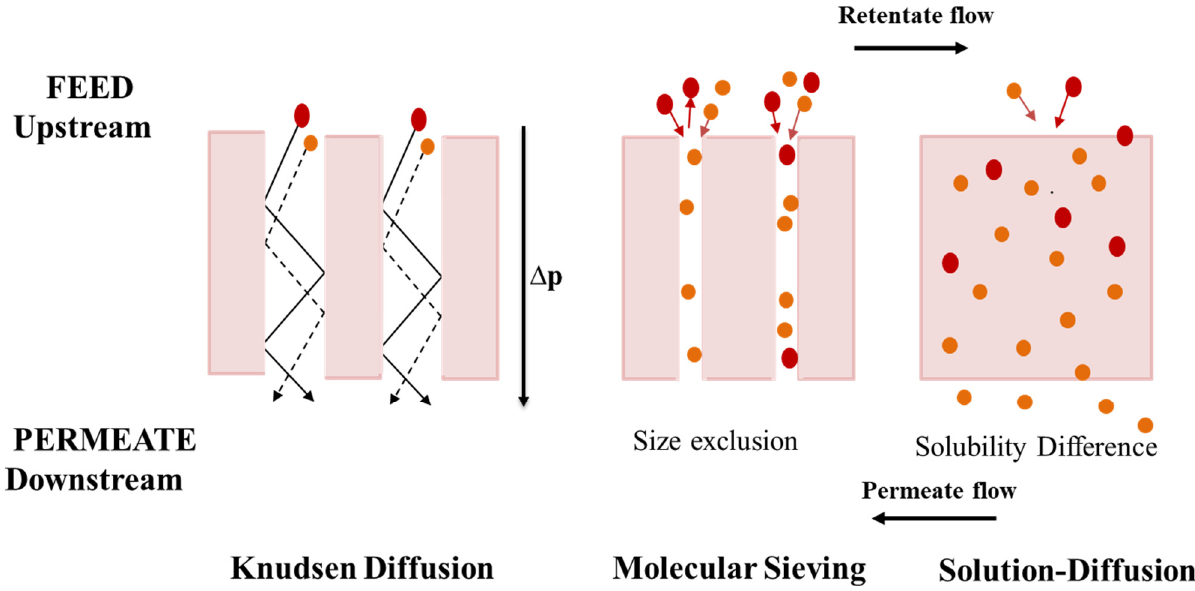
Figure 3. Schematic representation of the three mechanisms for gas mixture separation in membranes: diffusion—Knudsen diffusion, molecular sieving, and solution-diffusion. Orange circle (molecule A), Red circle (molecule B). The figure was adapted from Sridhar and co-workers, 2014, and Ismail and co-workers, 2015.